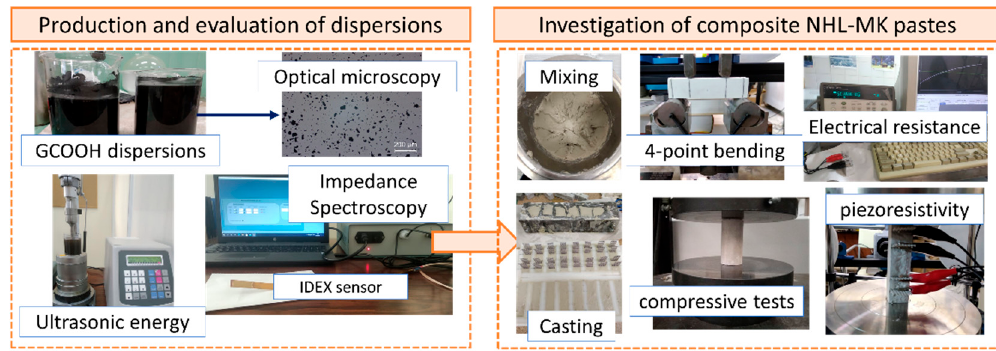
Figure 4. Summary of the experimental methods performed in the present